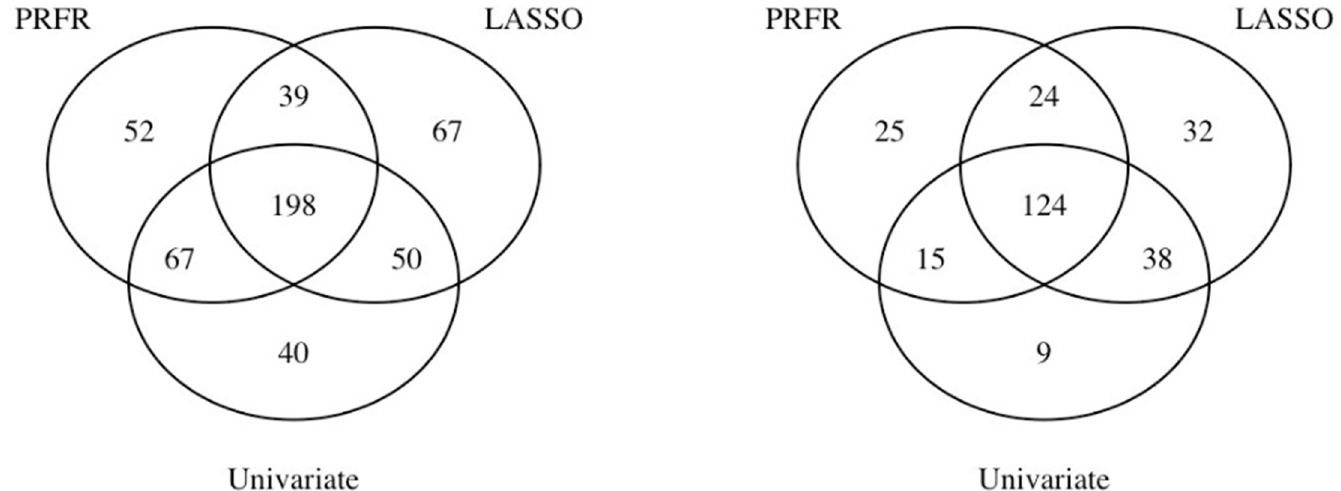
Fig 5. The number of overlapping top 50% prioritized SNPs between the three different methods (left); note that due to equally ranked SNPs, we used 354 and 355 highly ranked SNPs for LASSO and univariate methods, respectively, to closely match with the number for the PRFR method (356). The number of overlapping genes that were linked to the prioritized SNPs (right). Abbreviations : PRFR—preconditioned random forest regression; LASSO—least absolute shrinkage and selection operator.